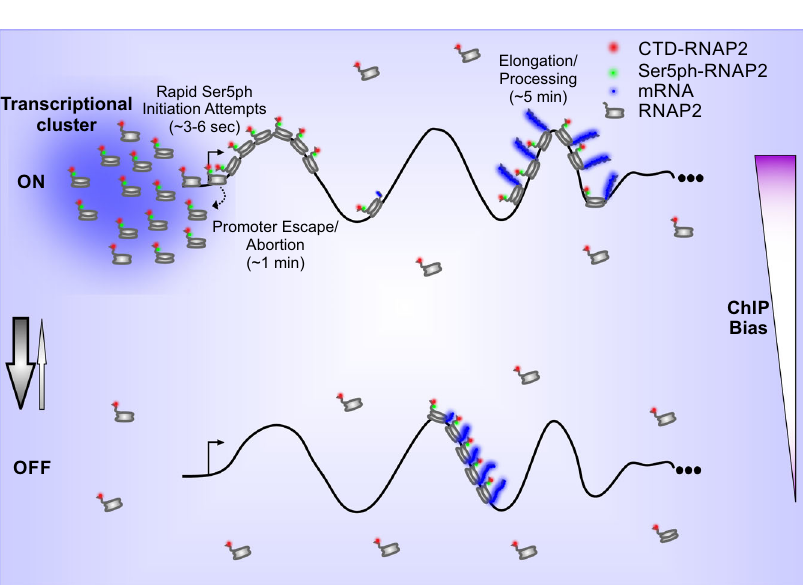
Fig. 5 Model depicting RNAP2 transcription dynamics in a single-copy gene. During extremely short (<<1 min) periods of the ON state, RNAP2 is recruited in bursts (~15 RNAP2) to the HIV-1 reporter gene, creating transient (~1 min) clusters of CTD-RNAP2 and Ser5ph-RNAP2 at the gene promoter, and initiating transcription in RNAP2 convoys (~7 RNAP2/convoy). The middle of the gene remains mostly empty due to rapid transcription, while a large number of RNAP2 (~15) concentrate at the end of the gene during processing (~4 – 5 min). In OFF periods (~2.3 min), RNAP2 convoys that escaped the promoter during the ON state quickly elongate and complete transcription. The gene rapidly transitions back to the OFF state when ON (denoted by arrows). ChIP assays enrich for genes with lots of RNAP2, which will bias the assay towards genes with RNAP2 clusters near the